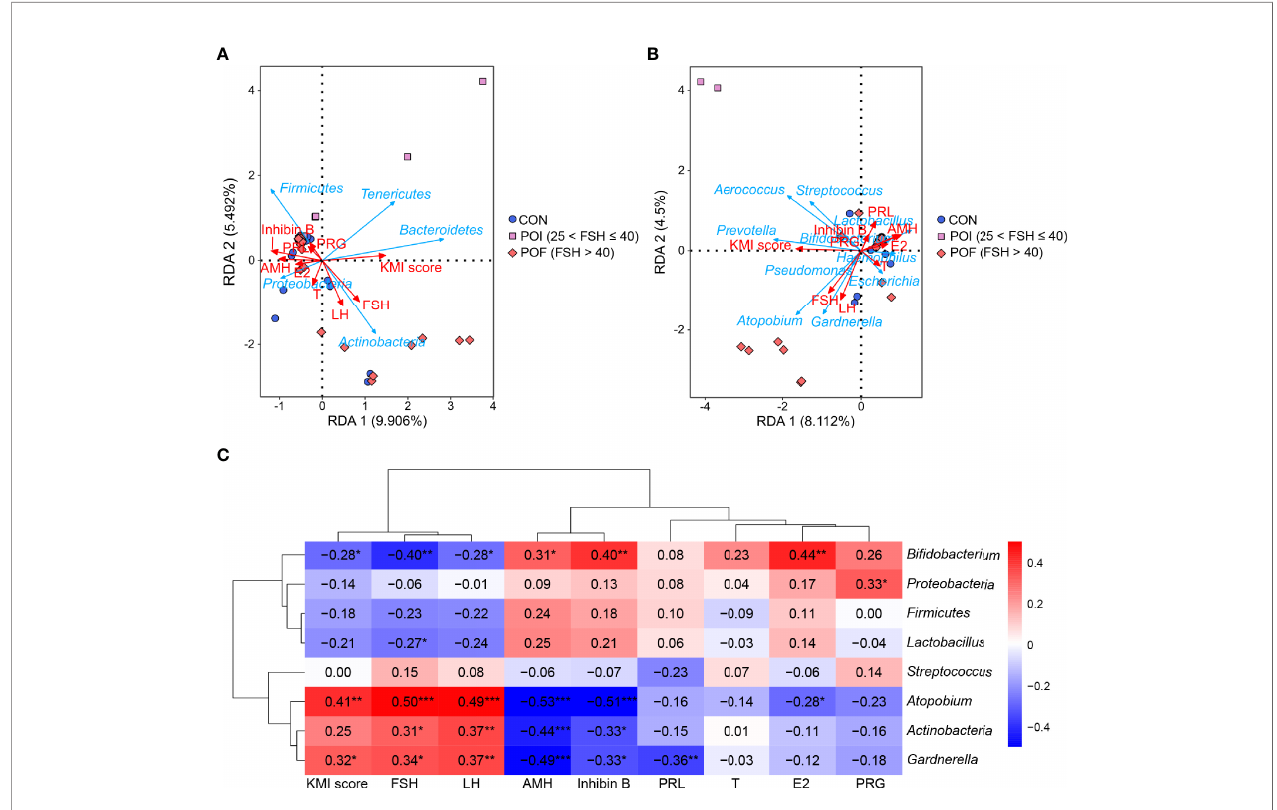
FIGURE 4 | Correlation analysis of vaginal microbiota with ovarian reserve, ovarian function, and KMI score. (A, B) RDA revealed the important relationships between the top fi ve phyla, the top ten genera, and clinical indicators related to ovarian reserve, ovarian function, and KMI score. (C) Spearman ’ s correlations between the relative abundance of vaginal microbiota and ovarian reserve, ovarian function, and KMI score. KMI, Kupperman index; FSH, follicle-stimulating hormone; LH, luteinizing hormone; AMH, anti-müllerian hormone; PRL, prolactin; T, testosterone; PRG, progesterone; E2, estradiol; RDA, redundancy analysis. P < 0.05 was considered statistically signi fi cant. * P < 0.05, ** P < 0.01, *** P <